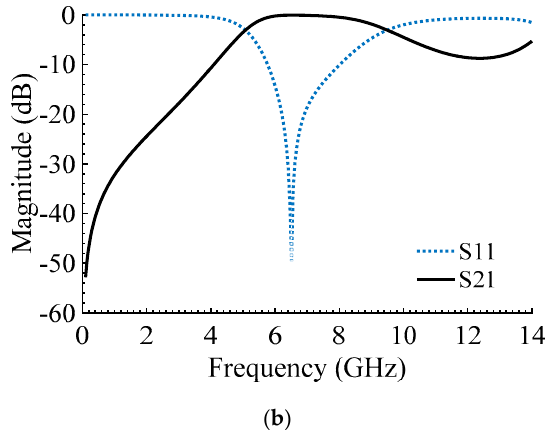
Figure 1. Coupling structure: ( a ) Layout, dg = 0.1, d1 = 6, d2 = 0.5, d3 = d4 = d5 = d6 = 0.2, d7 = 0.5 (unit: Mm), ( b ) electromagnetics simulation (EM).